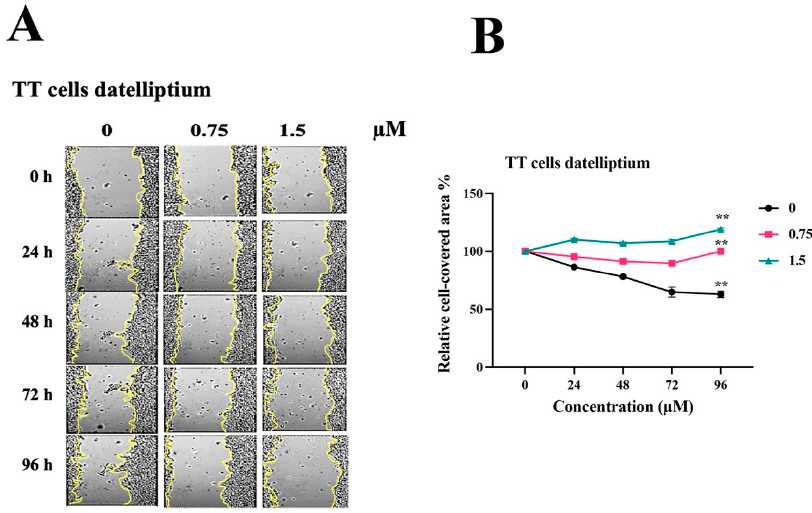
Figure 3. Effects of datelliptium on the migration of TT cells. ( A ) A narrow scratch was created in a confluent monolayer of TT cells growing on the bottom of a 12-well plate and incubated at 37 °C for 96 h. ( B ) Relative cell covered area analysis of wound closure in ( A ). ( n = 3, ** p ≤ 0.01).